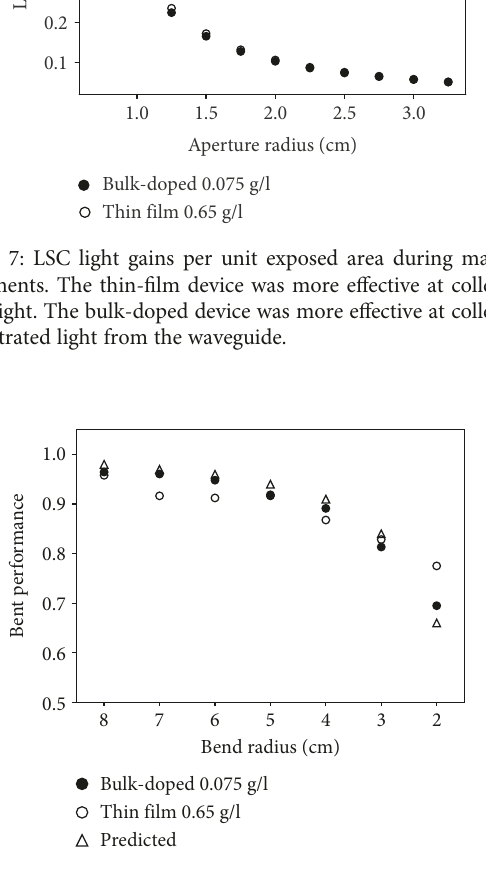
Figure 8: Bent waveguide performance. Values represent the bent waveguide light gains scaled by the fl at waveguide light gains. Both devices performed similarly to predicted values determined by the fraction of light intercepted by the bent